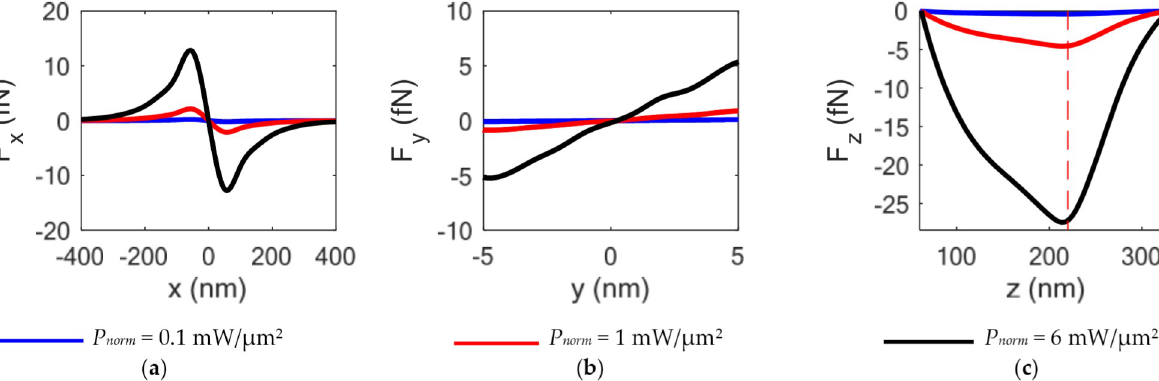
Figure 5. Optical forces F x , F y , and F z , varying the input power P norm and considering a particle with d = 100